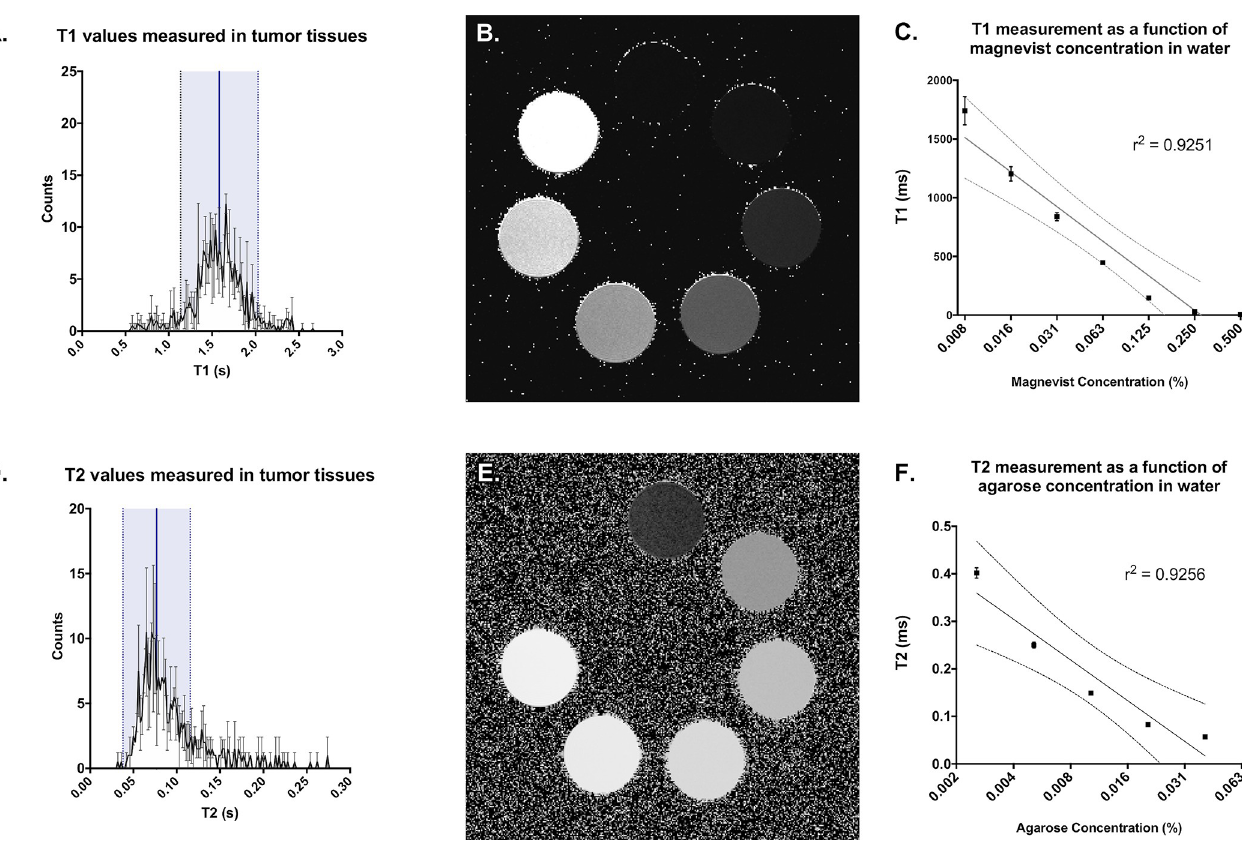
Fig 3. T1 and T2 fitting across a preclinical soft tissue sarcoma demonstrate the anticipated T1 signal range of tumors on study. Histograms of T1 (A), and T2 (D) values measured in sarcoma tissues are shown, including the mean (blue line) and 2 standard deviations (shaded light blue). Bottles containing a dilution series of magnevist (B) and agarose (E) were measured in the 72 mm volume coil and used to mimic the ranges of T1 and T2 values in tumor during construction of a custom study phantom. Linear regressions of T1 or T2 measurements (C and F, respectively) were plotted along a log scale of solution concentration and shown with 95% CI (dotted